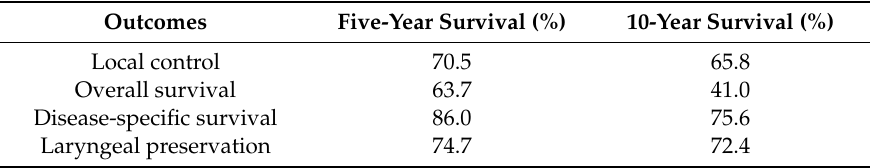
Table 2. Five- and ten-year oncological